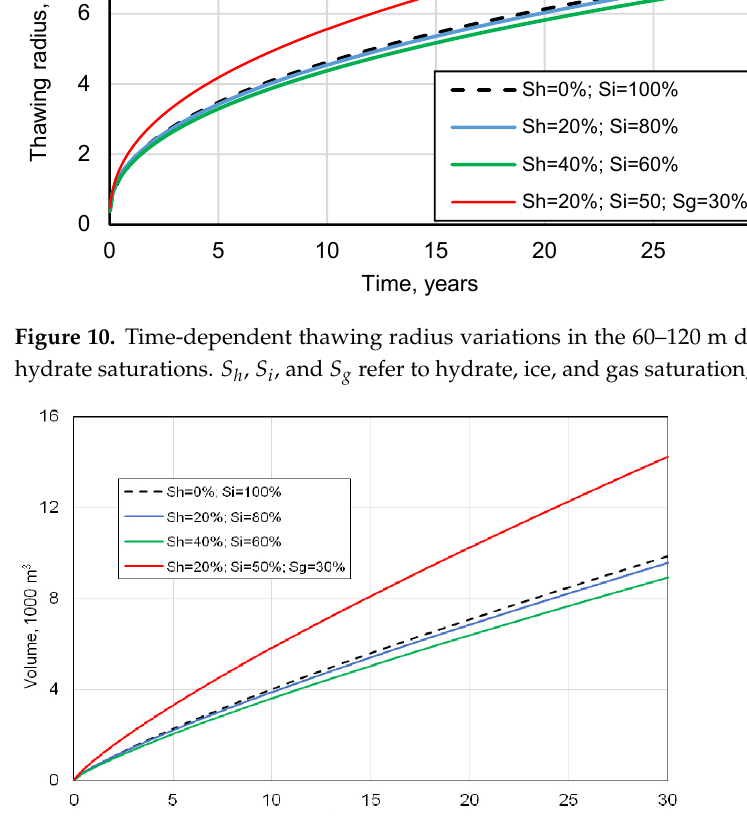
Figure 9. Mean annual permafrost temperature variations around a producing gas well at depths 1, 10, 20, 30, and 40 m, after 30 years of operation. Permafrost contained gas hydrates in the depth interval of 60 ‒ 120 m, with hydrate saturation 𝑆 (cid:3035) = 20%; hydrate+ice saturation 𝑆 (cid:3035) + 𝑆 (cid:3036) = 70%. The thaw radius in permafrost-bearing gas hydrates depends on the total Sh+Si sat- uration (Figure 10), that is, about 25% larger in the case of 𝑆 (cid:3035) + 𝑆 (cid:3036) = 70% than at 𝑆 (cid:3035) + 𝑆 (cid:3036) = 100%. The reason is that the presence of free pore space filled with methane (30% in our case) decreased the phase transition enthalpy for both ice and gas hydrate and, thus, ac- celerated the thawing.